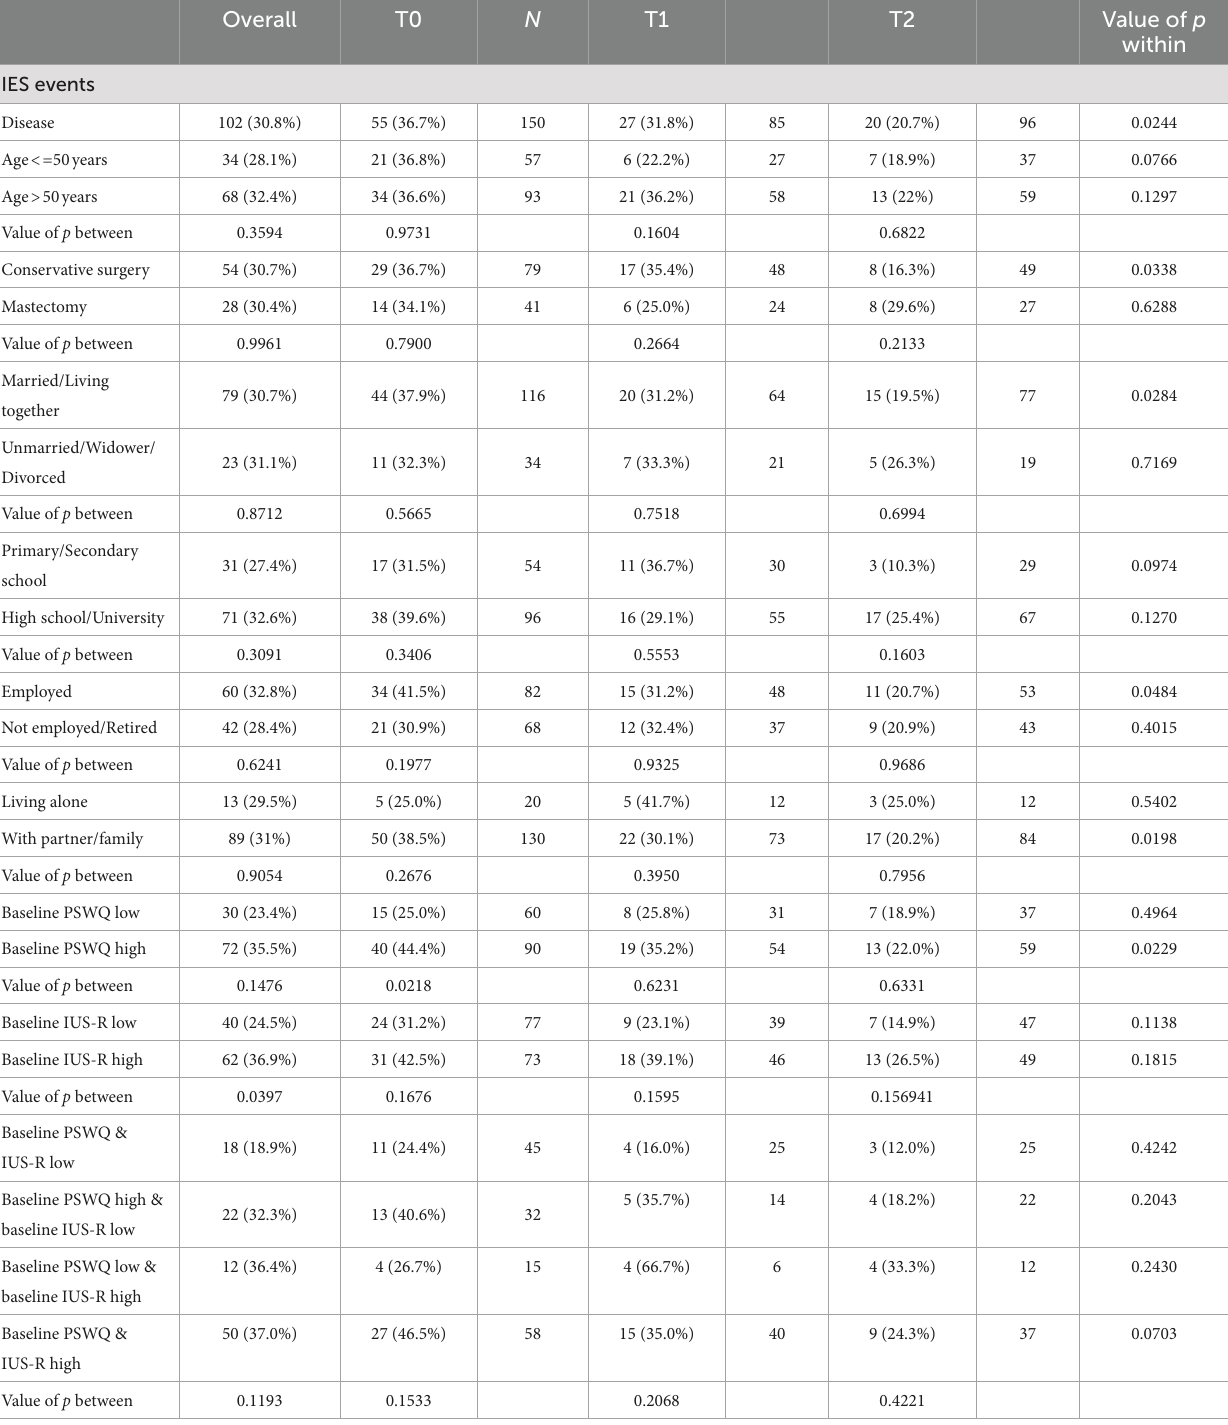
TABLE 3 Frequency of events reported over time: overall and according to patient characteristics (T0: N = 150; T1: N = 85; T2: N = 96). Overall T0 N T1 T2 Value of p